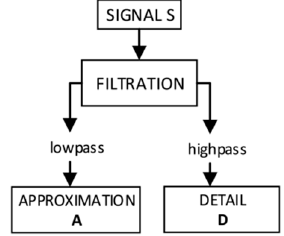
Figure 9. Diagram of wavelet decomposition [45].